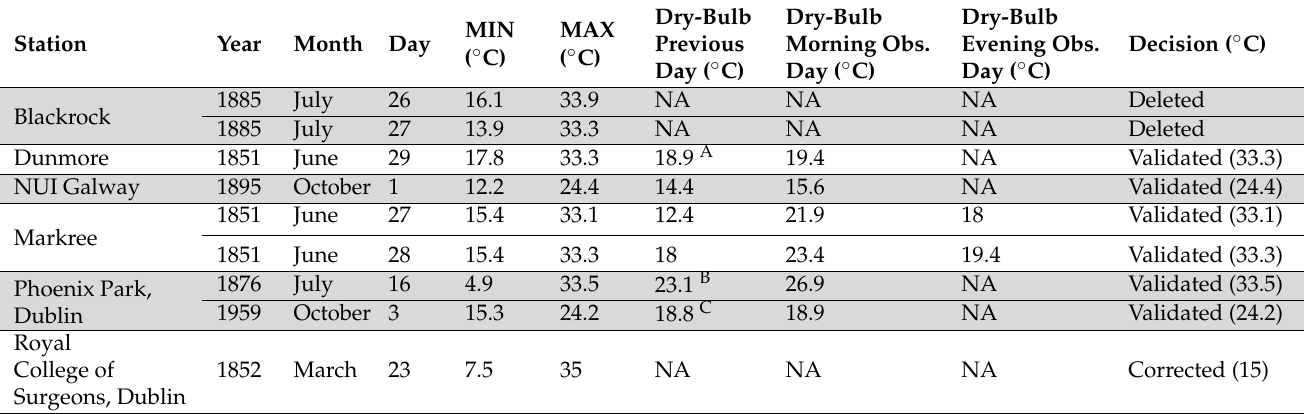
Table A4. Flagged upper daily MAX threshold exceedance (flag 4) and the dry-bulb thermometer registered on previous and observation